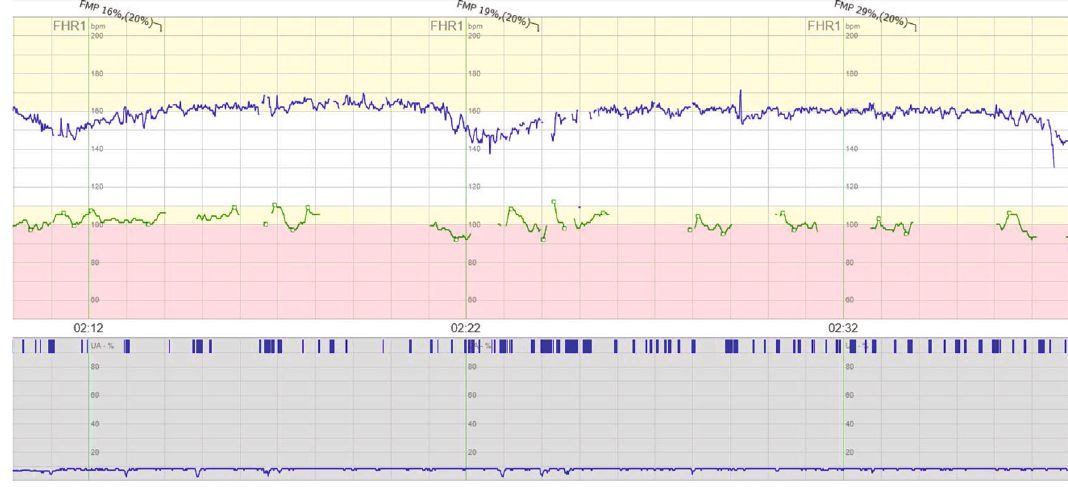
Figure 7: Patient 5 CTG at admittance to the